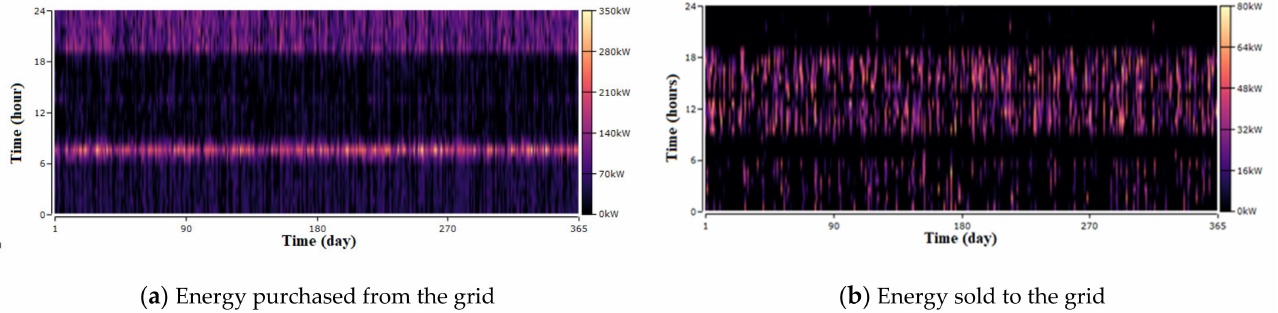
Figure 9. Kudat, FH-5000 wind turbine case.